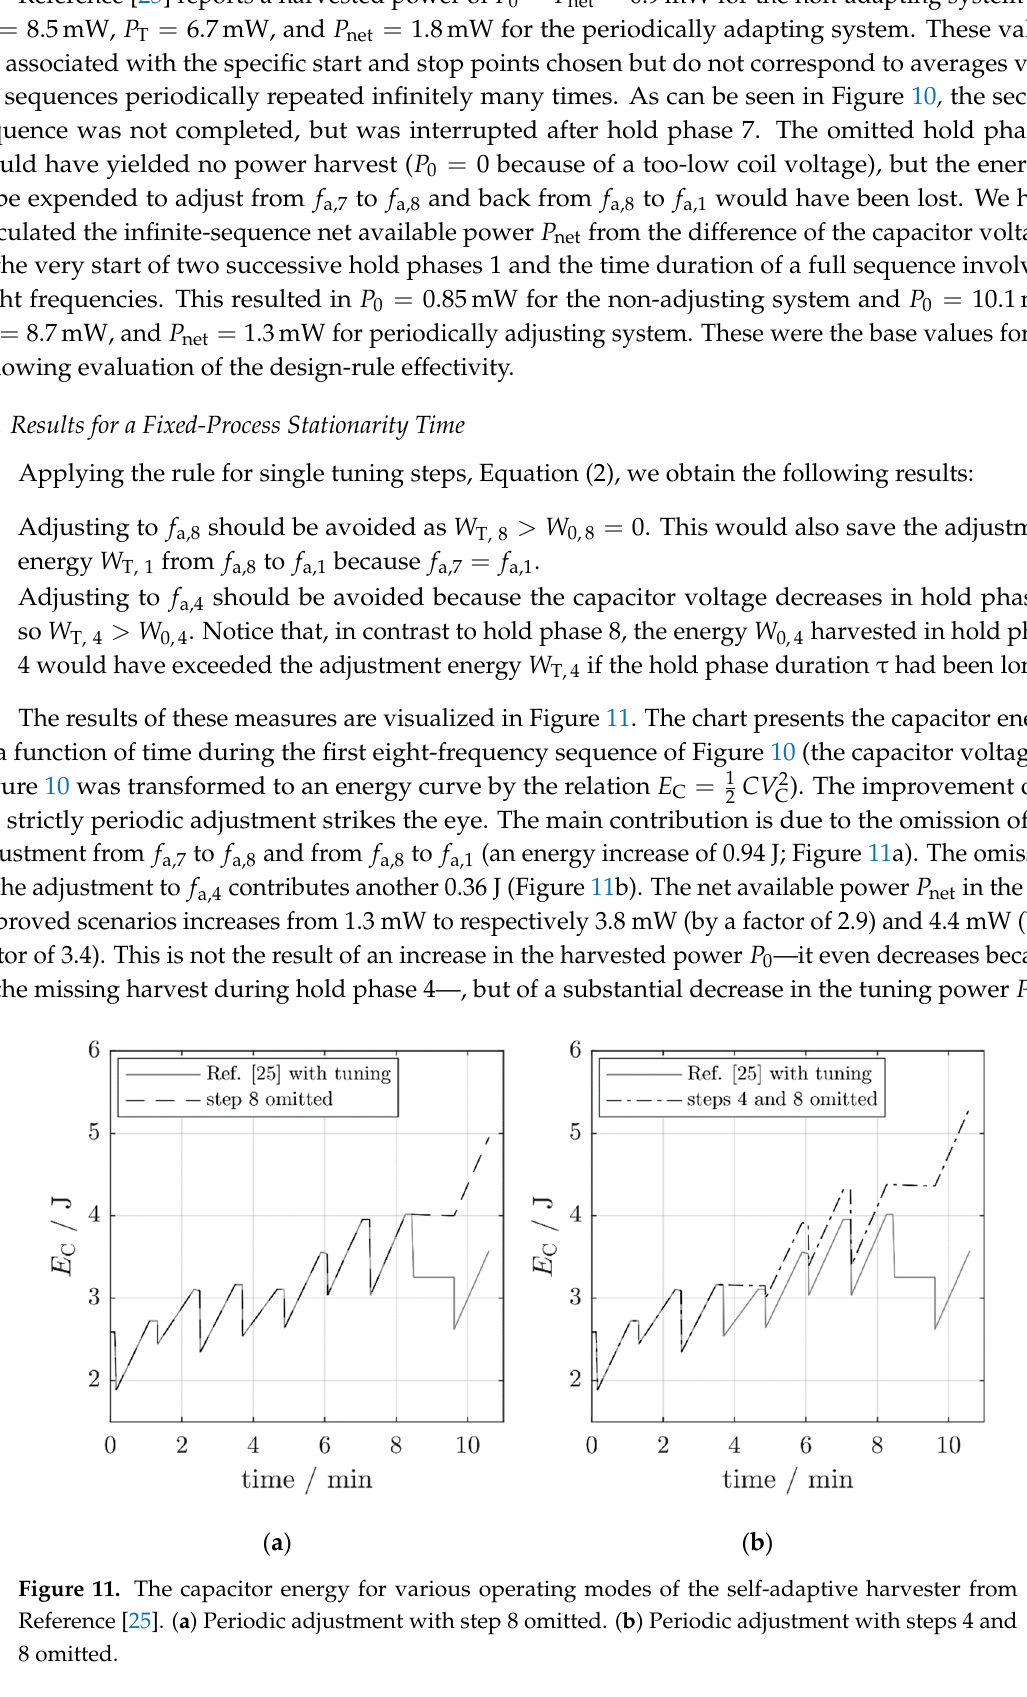
( a ) ( b ) Figure 12. The capacitor energy for various operating modes of the self-adaptive harvester from Ref. [25]. ( a ) Operation with a narrowed adjustment bandwidth (s = 0.58). ( b ) Comparison with the results from Figure 11. 5.3. Influence of the Process Stationarity Time Hoffmann et al. [25] also attempted to supply a constant load with